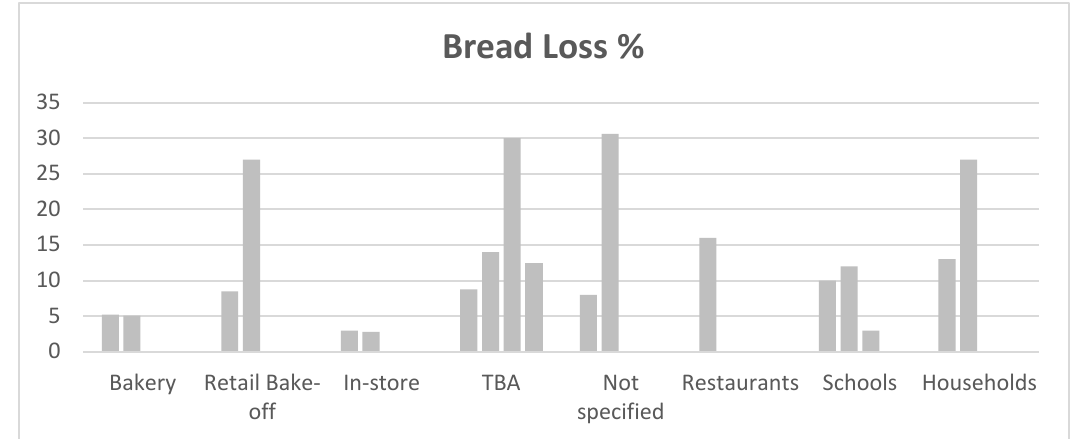
Figure 1. Bread loss (percentage) from Table 2.